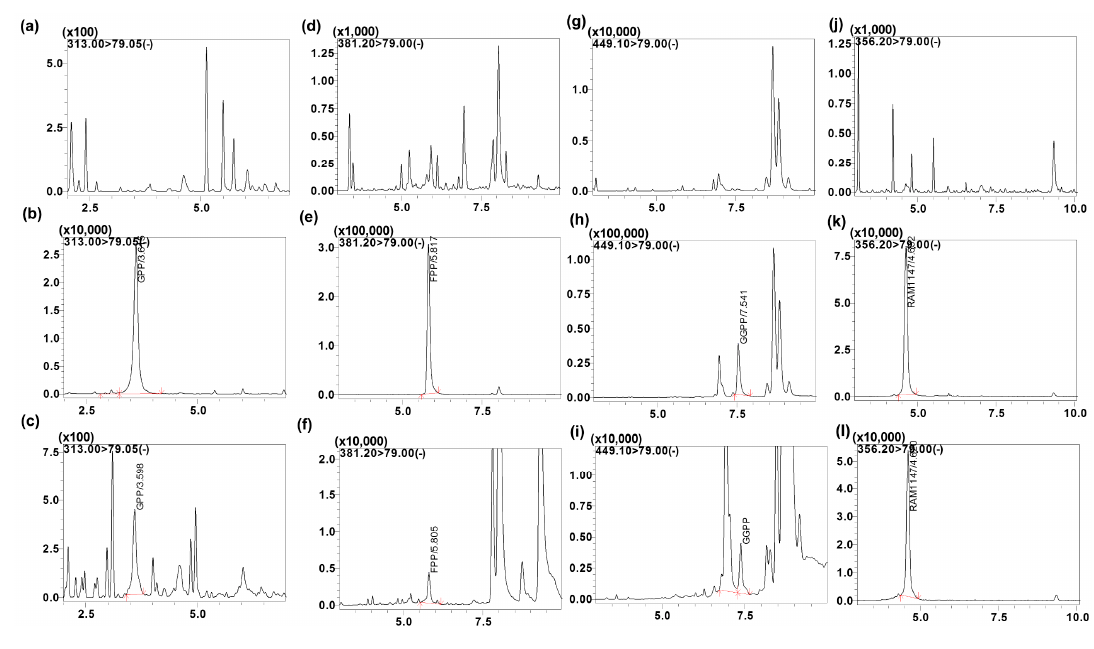
Figure 3. Representative MRM ion-chromatograms of ( a ) blank charcoal-stripped plasma (GPP), ( b ) GPP spiked in charcoal-stripped plasma (rt, 3.6 min,10 ng/mL), ( c ) Blank human plasma sample of GPP, ( d ) blank charcoal-stripped plasma (FPP), ( e ) FPP spiked in charcoal-stripped plasma (rt, 5.8 min,10 ng/mL), ( f ) Blank human plasma sample of FPP, ( g ) blank charcoal-stripped plasma (GGPP), ( h ) GGPP spiked in charcoal-stripped plasma (rt, 7.5 min,10 ng/mL), ( i ) Blank human plasma sample of GGPP, ( j ) blank charcoal-stripped plasma (RAM1147), ( k ) RAM114 spiked in charcoal-stripped plasma (rt, 4.7 min,10 ng/mL), ( l ) Blank human plasma sample spiked with